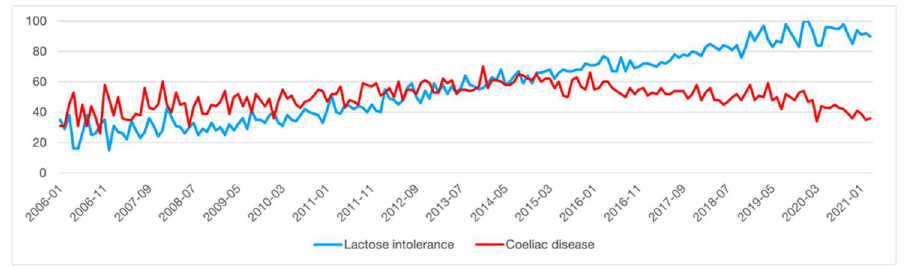
Figure 1. The increasing interest in lactose intolerance in recent years, from 2015 especially, compared to coeliac disease interest. The x axis indicates a period ranging from 2006 to 2021, while the y axis represents the interest normalized by Google Trends to the time and location of the query (modified by Google Trends [6]).